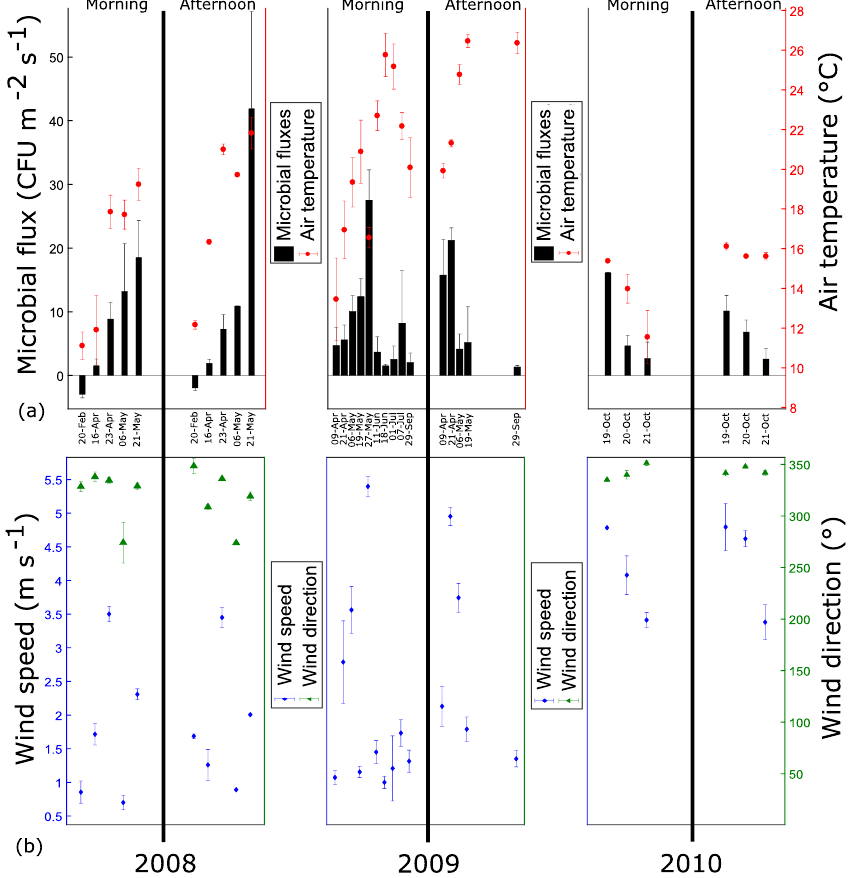
Figure 6. Temporal dynamics of observed microbial fluxes, air temperature, wind speed and wind direction in the 2008, 2009 and 2010 field campaigns. Panel (a) shows time series of air temperature and microbial fluxes for the campaigns held between 2008 and 2010. Panel (b) shows the time series of wind speed and wind direction for the same period. No wind direction data were available for the year 2009. For both (a) and (b) morning and afternoon averages are reported with the relative standard error in the error